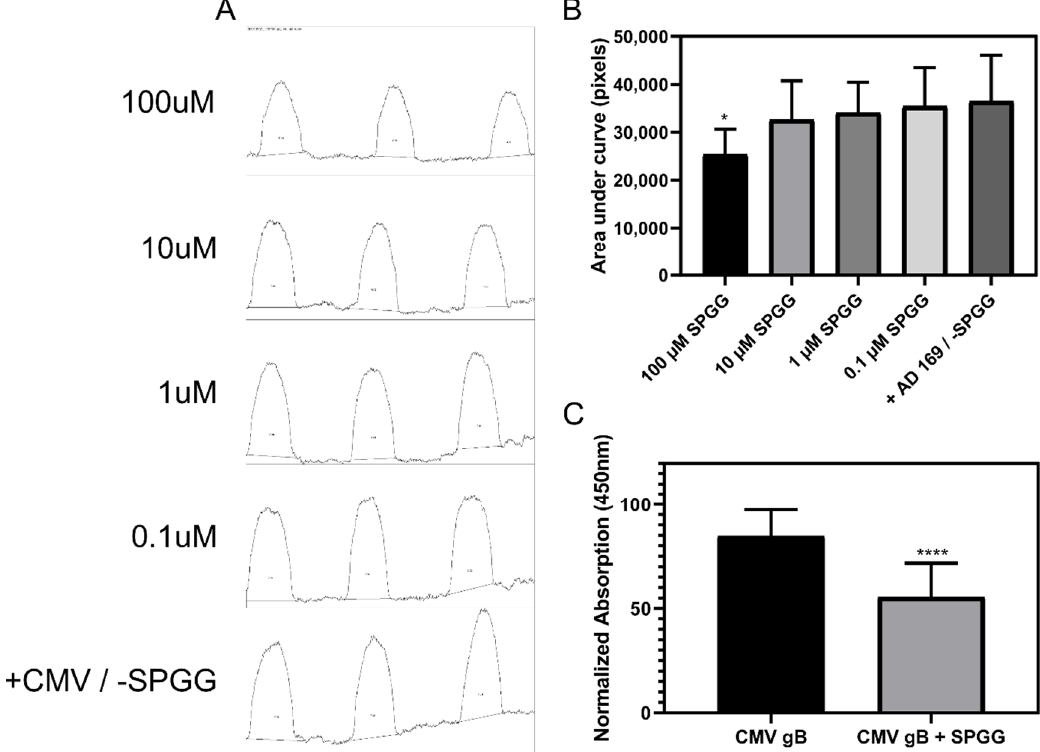
Figure 6. Displays moderate affinity for HCMV entry glycoprotein B (gB) in two independent assays. Panels ( A ) and ( B ): Dot blot analysis showing one possible mechanism behind SPGG’s inhibition of HCMV entry. Spots containing 5 × 10 5 PFU of HCMV AD169 strain and dilutions of SPGG were applied to nitrocellulose membrane and an immunoassay was carried out. The signal was then quantified for size and pixel density using ImageJ gel analysis function and the profile plot was generated with each curve representing a respective spot on the original blot (panel A ). The area under each curve in ( A ) was then calculated and plotted in (panel B ). Panel ( C ): Cell-ELISA was used to assess the affinity of SPGG for HCMV gB over-expressed in CHO-K1 cells. Each experimental condition was tested in at least triplicate with an N = 4. The errors in ( B ) and ( C ) correspond to + SD. ANOVA determined significant differences among means with a P -value of 0.0273 (*) in ( B ). Further analysis of ( B ) using Dunnett’s multiple comparison test found a significant difference in the 100 µM treatment when compared to the mean of the positive control with a P -value of 0.0117 (*). T-test analysis was used to determine significance in ( C ). (****) signifies a P -value of <